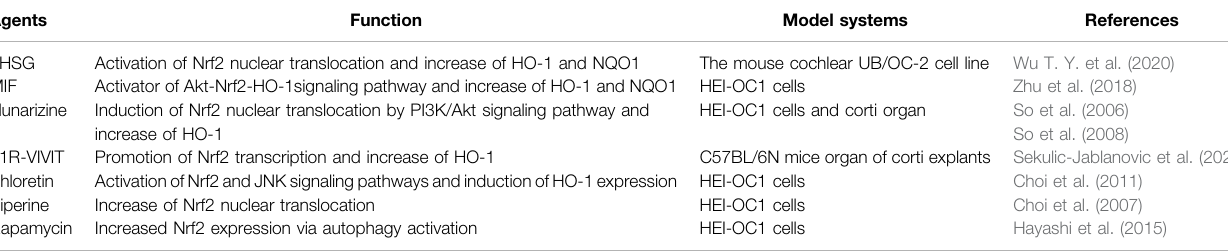
TABLE 1 | Drugs acting on Nrf2 for hearing protection in vitro studies.